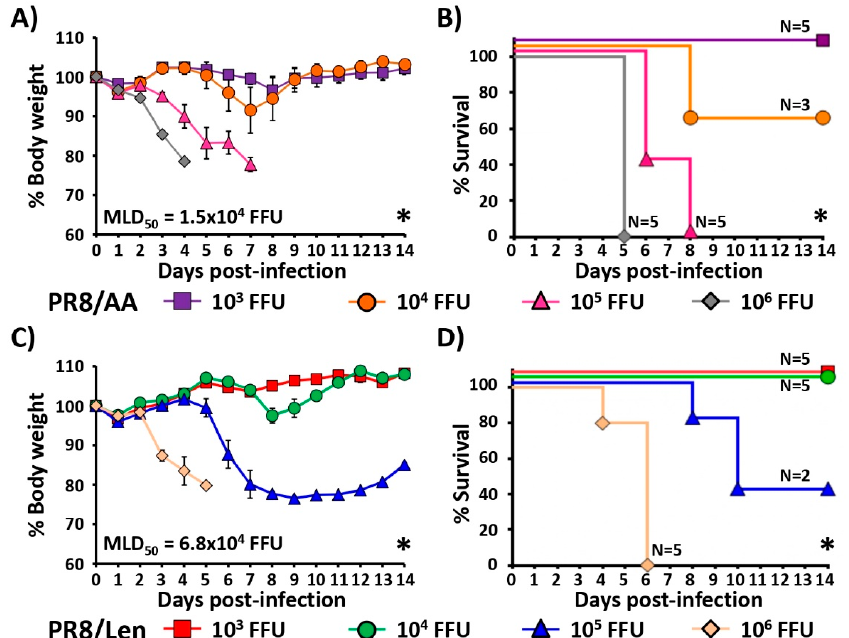
Figure 4. Attenuation of PR8 / AA and PR8 / Len viruses in vivo. Six-to-8-week-old female C57BL / 6 mice ( n = 5) were infected intranasally (i.n.) with the indicated FFU of PR8 / AA ( A , B ) or PR8 / Len ( C , D ) viruses and then monitored daily for 2 weeks for body weight loss ( A , C ) and survival ( B , D ). Mice that lost 25% of their initial body weight were sacrificed. Data represent the means and SDs of the results determined for individual mice ( n = 5). The viral 50% mouse lethal dose (MLD 50 ) for PR8 / AA and PR8 / Len were calculated based on survival data using the method of Reed and Muench [50]. ( A , C ) Statistical analysis was performed using one-way ANOVA test comparing % body weight loss between groups (* P < 0.0001). ( B , D ) Statistical analysis was performed using log-rank (Mantel-Cox) test (* P < 0.0001).